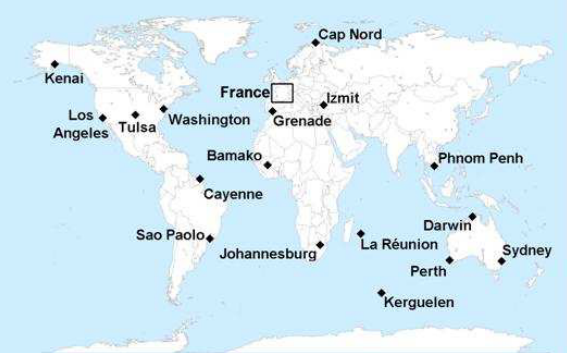
Figure 2: biases assessment using well known geographic sites